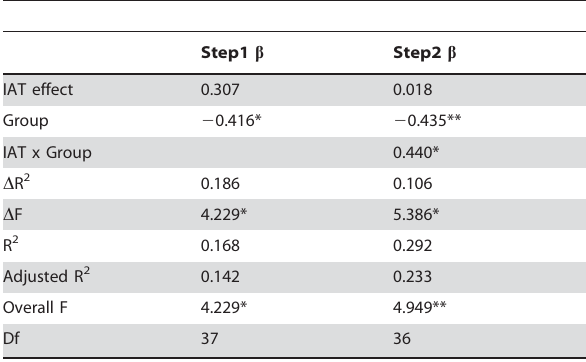
Table 3. Hierarchical Regression Analysis on IAT effect with the self-face advantage as the Dependent